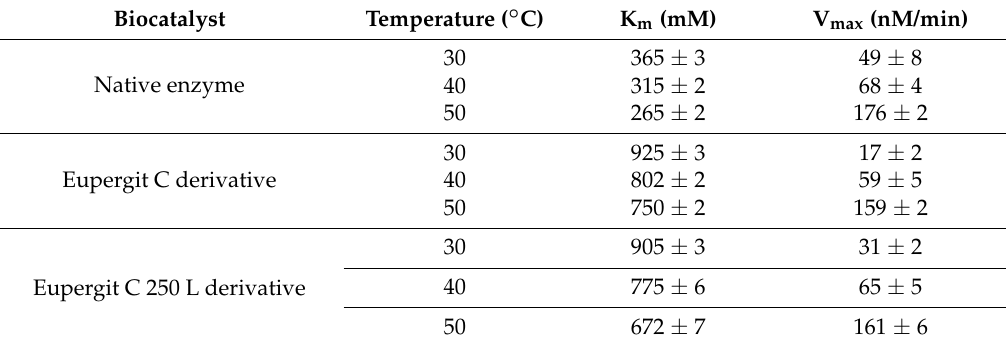
Table 4. Kinetic parameters for soluble D -xylose ( D -glucose) isomerase and derivatives.